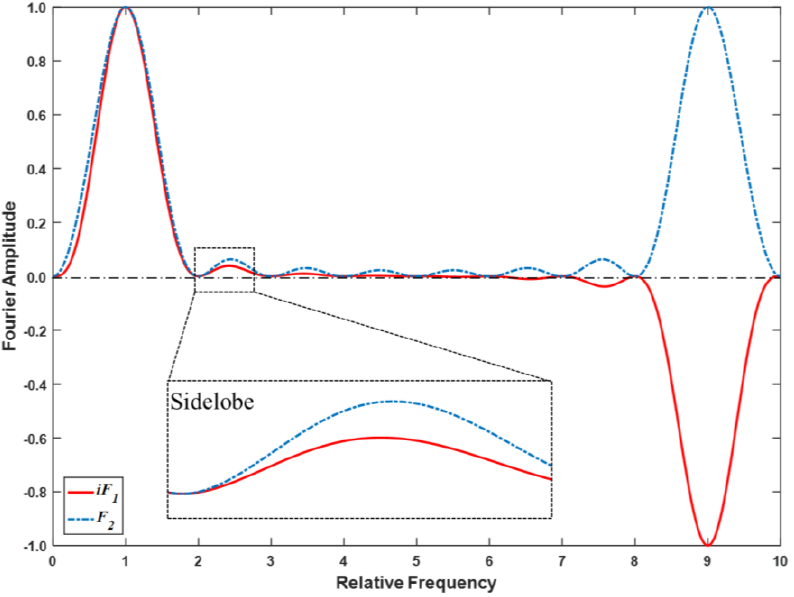
Figure 5. Sampling functions of Surrel’s 2 N − 1 algorithm ( N = 10).